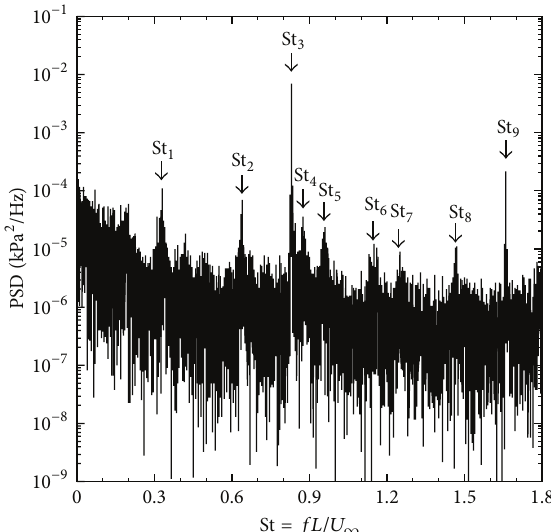
Figure 2: Power spectral density of pressure oscillation for 𝐿/𝐷 = 0.70 [7].